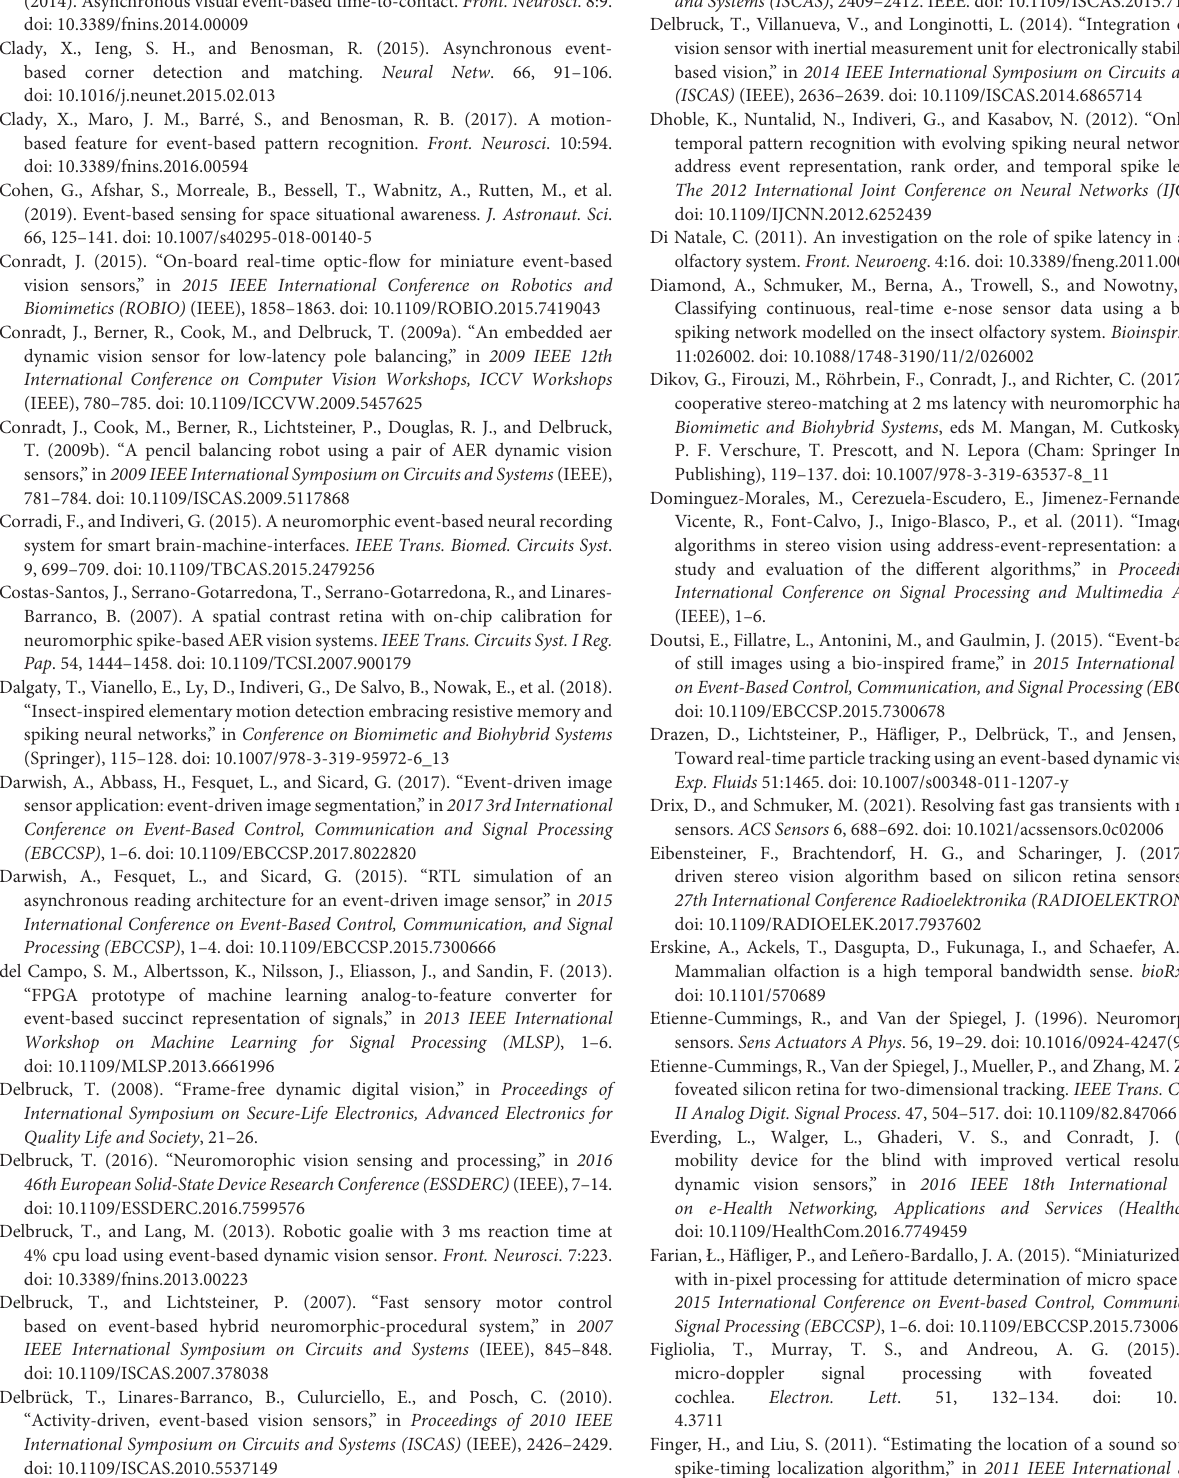
Figliolia, T., Murray, T. S., and Andreou, A. G. (2015). Acoustic micro-doppler signal processing with foveated electronic cochlea. Electron. Finger, H., and Liu, S. (2011). “Estimating the location of a sound source with a spike-timing localization algorithm,” in 2011 IEEE International Symposium of Circuits and Systems (ISCAS) , 2461–2464. doi: 10.1109/ISCAS.2011.59 38102